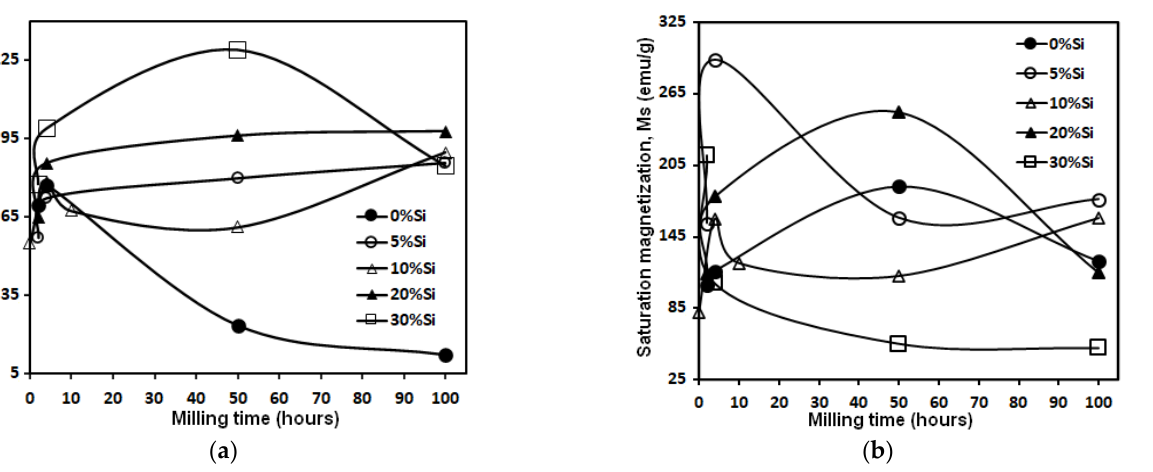
Figure 5. The evolution of the coercivity (Hc) ( a ) and the saturation magnetization (Ms) ( b ) of the MA Fe 60 − x Co 25 Ni 15 Si x (x = 0, 5, 10, 20, and 30 at%Si) alloys on the milling time. (Units: 1 Oe = 10 − 4